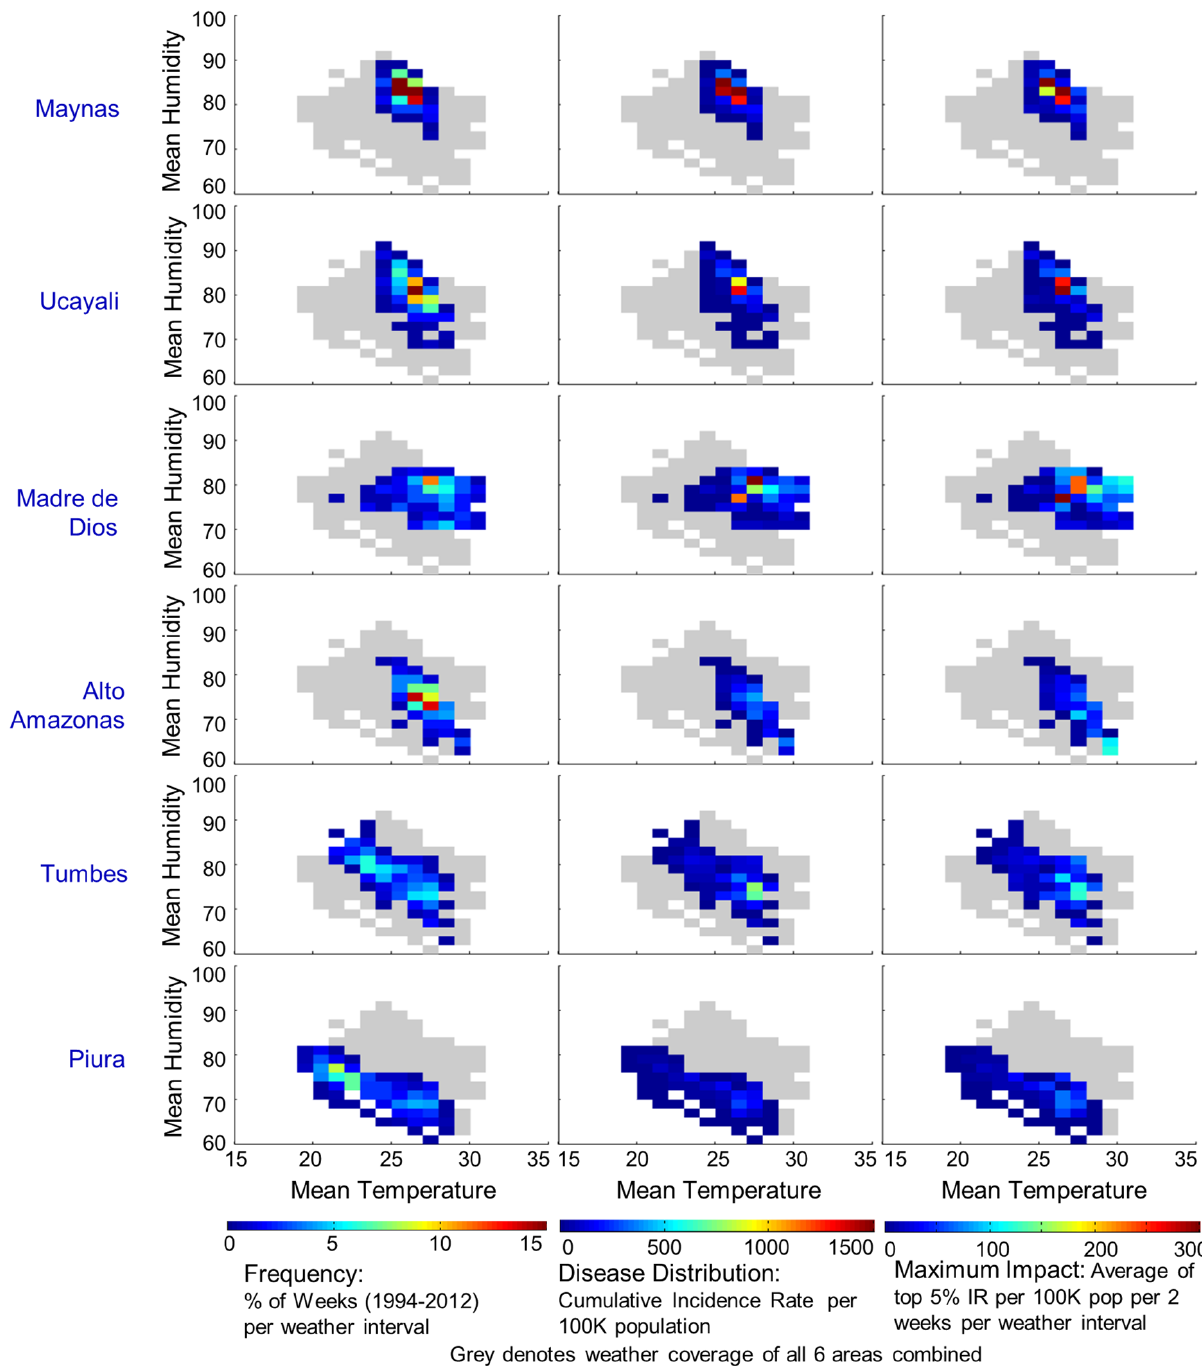
Fig 5. Distribution of dengue in mean temperature-humidity weather-space for 6 high transmission locations in Peru. Left column: The frequency distribution of weather intervals (where time is spent) annually is shown for each location. Center column: The distribution of dengue cases across weather- space is shown for each location. Right column: Maximum dengue impact across weather-space is shown for each location. Locations are ordered top to bottom by highest mean humidity when temperature is optimal for transmission. Locations with higher humidity during optimal temperature are observed as having higher maximum dengue